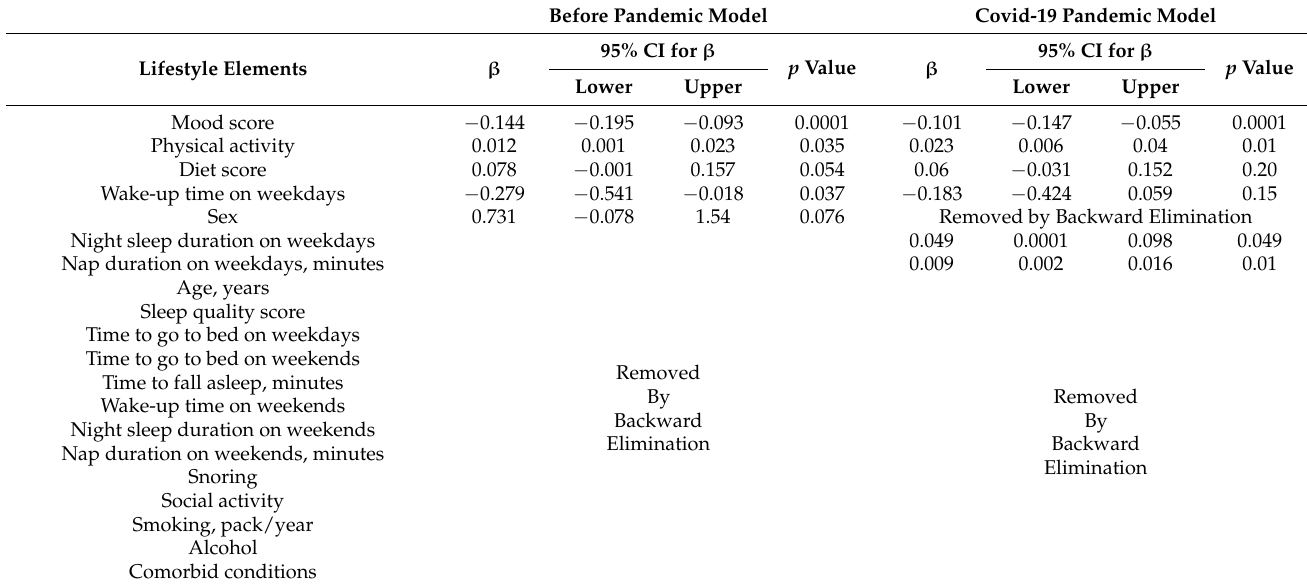
Table 4. Multivariable linear regression models of the self-rated wellness and health index comparing the pre-pandemic and pandemic